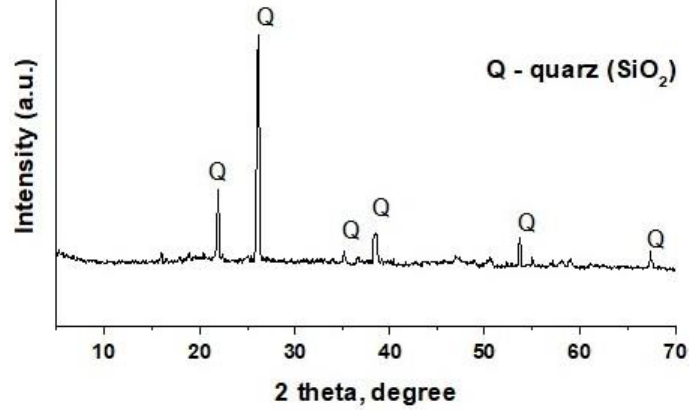
Figure 2. XRD pattern of the sand sample. Thus, the sand sample used was almost entirely quartz particles. As a result, the utilised demulsifiers are subsequently referred to as quartz particles in this article. After milling the selected portion of sand, particles of a more or less uniform shape were obtained (Figure